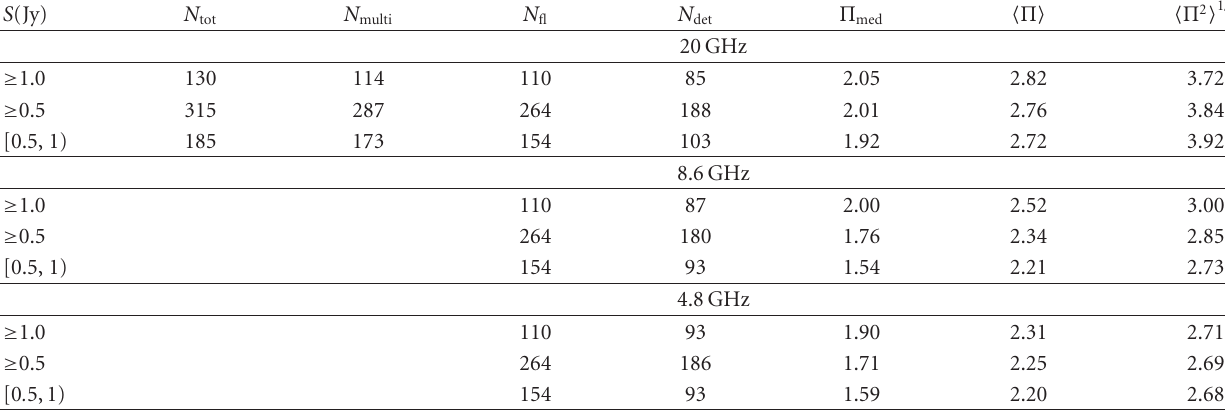
Table 1: Median, mean, and (cid:9) Π 2 (cid:10) 1 / 2 of the fractional polarization for flat-spectrum sources in the almost complete subsample of the AT20G surveys at di ff erent observational frequencies and flux ranges. N tot refers to the total number of objects in the corresponding flux range; N multi to the number of objects with 5- and 8-GHz measurements; N fl to the number of flat-spectrum sources; N det to the number of flat-spectrum sources with polarization